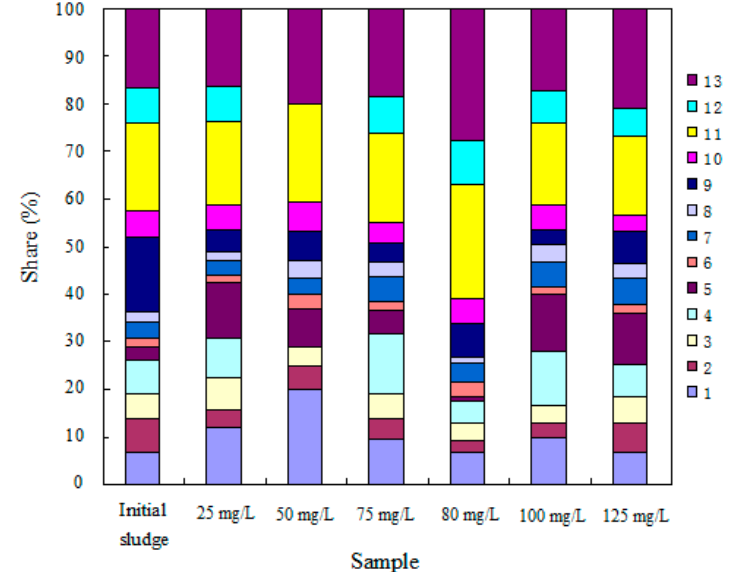
Figure 4. Relative proportions of the dominant microbial populations from the denaturing gradient gel electrophoresis bands in sludge samples from anammox reactors containing different Ca 2+ concentrations. The numbers in the legends refer to the band numbers in Figure 3. Sample 1, initial sludge; Sample 2, (Ca 2+ ) = 25 mg/L; Sample 3, (Ca 2+ ) = 50 mg/L; Sample 4, (Ca 2+ ) = 75 mg/L; Sample 5, (Ca 2+ ) = 80 mg/L; Sample 6, (Ca 2+ ) = 100 mg/L; Sample 7, (Ca 2+ ) = 125 mg/L.